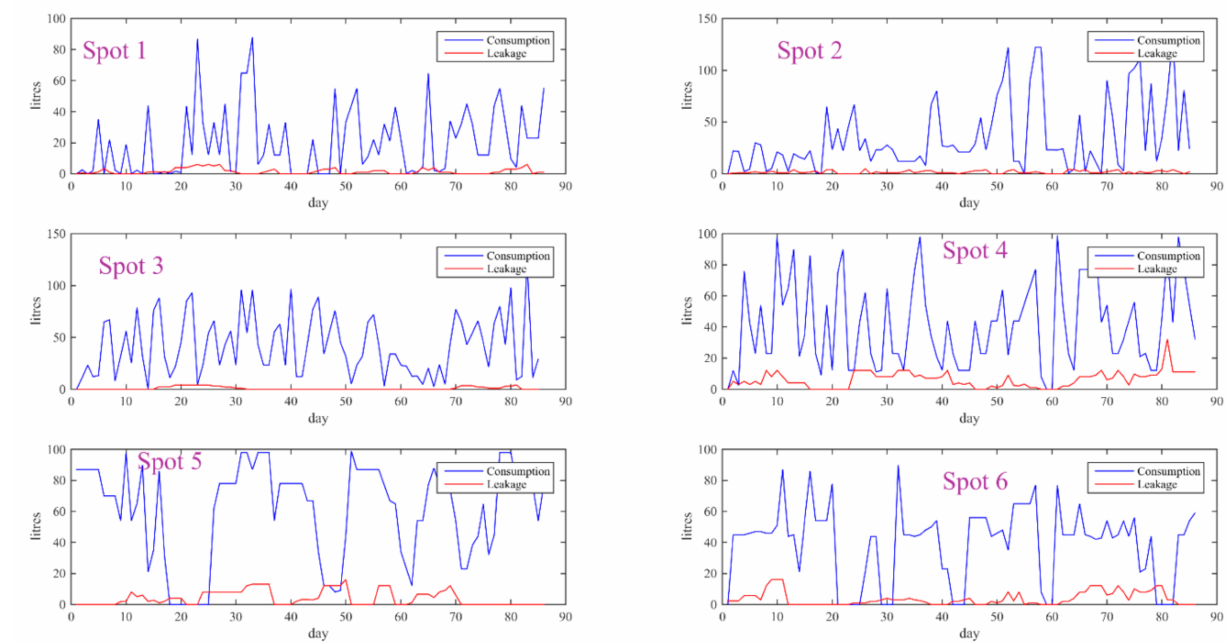
Figure 5. Monitoring the consumption and leakage pattern in all six spots where the IoT application was